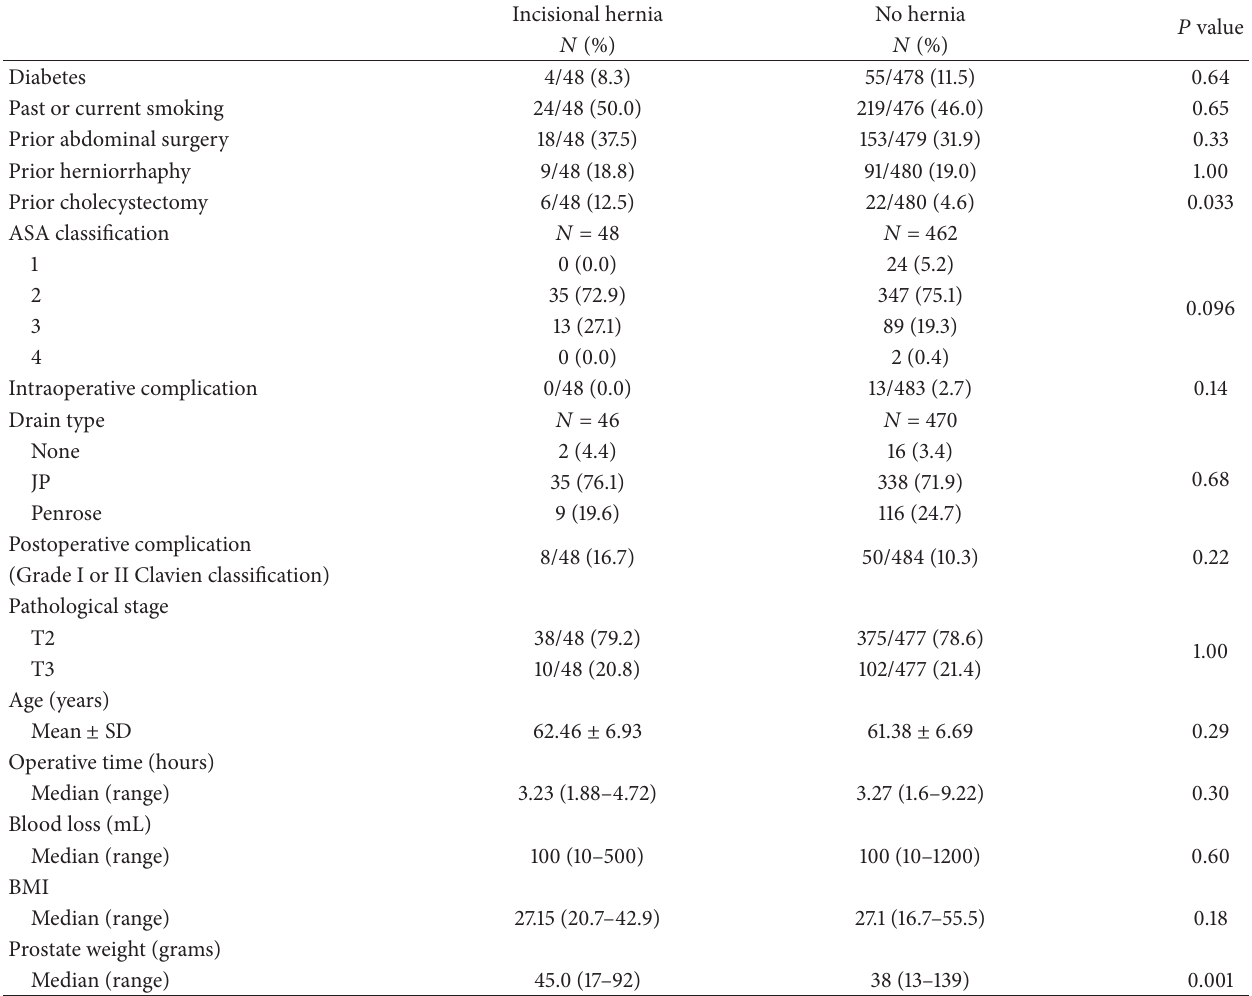
Table 3: Comparison of incisional hernia versus no hernia groups on potential risk